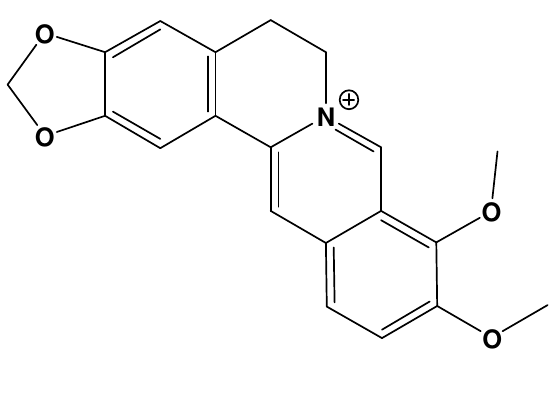
Figure 1. Molecular structure of